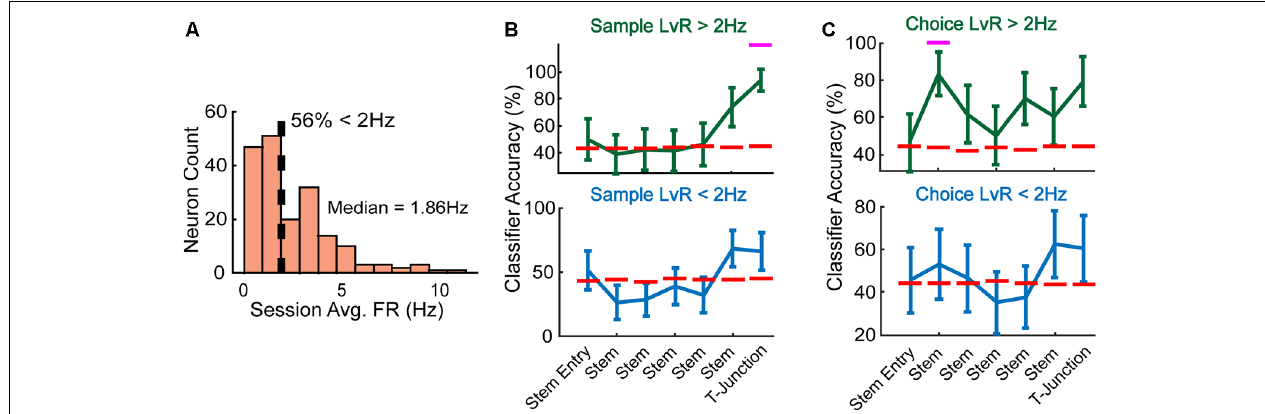
FIGURE 5 | High-rate neurons reflect current and future behavior during well-learned DNMP performance. (A) Fifty-six percentage of neurons exhibited a session averaged firing rate < 2 Hz, a firing rate that approximated the median of 1.86 Hz. We split the data according to a 2 Hz threshold (dashed line) and define high-rate neurons as having a firing rate that exceeds the 2 Hz threshold, and low-rate neurons as having a firing rate that is below 2 Hz. (B) Top panel: high-rate neurons collectively predicted current trajectory at T-junction during sample phase ( Z = 2.7, p = 0.007, N = 89 neurons). Bottom panel: low-rate neurons do not collectively reflect trajectory information ( N = 98 neurons). Magenta lines indicate significance using a z -test (see “Materials and Methods” section). Data are represented as mean ± standard deviation of classification accuracies. (C) Top panel: high-rate neurons collectively predicted the future trajectory during early stem traversals ( Z = 2.1, p = 0.036), but exhibited a trending effect at T-junction ( Z = 1.9, p = 0.053). Bottom panel: low-rate neurons do not collectively reflect trajectory information on the choice phase. Data are represented identically as described in panel (B)